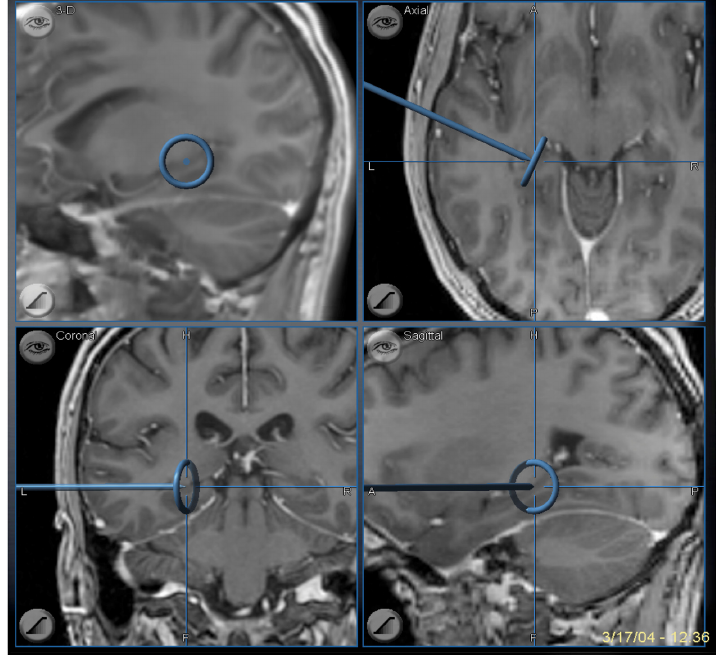
Figure 9. Image guidance view of the navigation pointer at the posterior extent of the hippocampal removal, which corresponds to the level of the midbrain tectum.